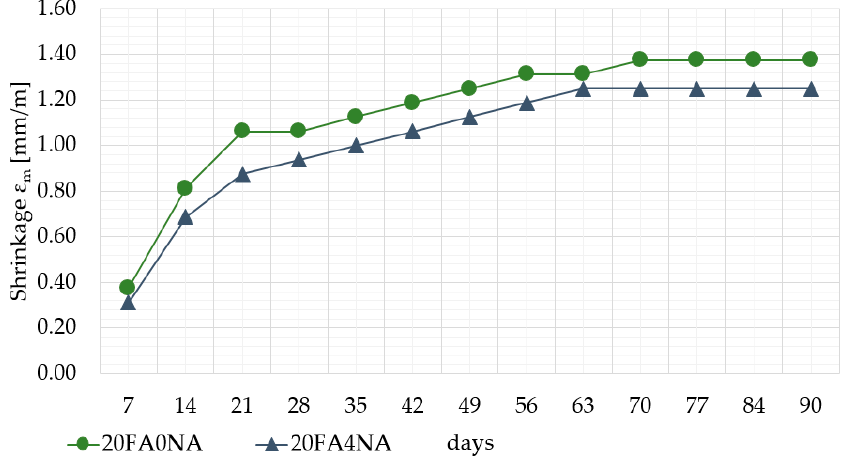
Figure 5. Deformations ε m of the tested pastes. Significant changes in measurements of the rheological shrinkage values started to be observed from the 7th day of mixtures maturation. Earlier shrinkage was almost unnoticeable and was within the limits of measurement error (in this period minimal shrinkage values of about 0.1 mm/m were